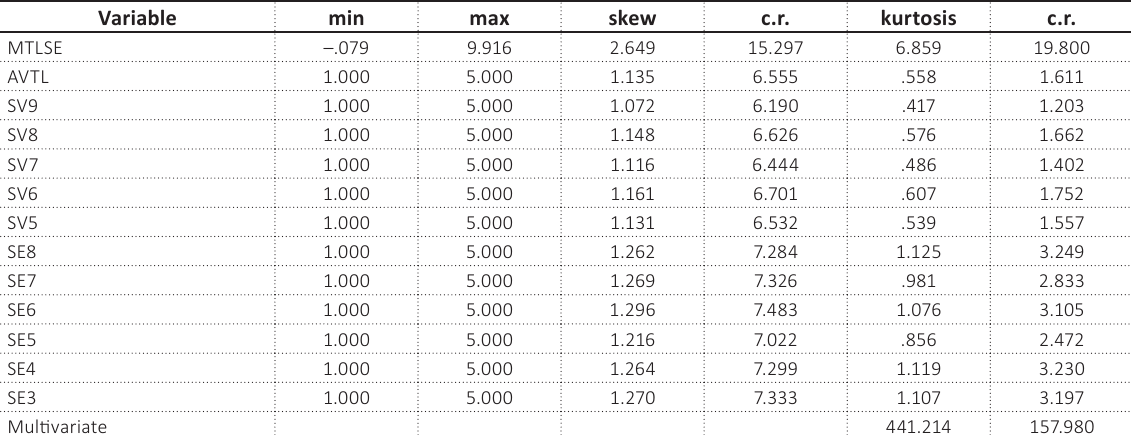
Table 4. Normality test